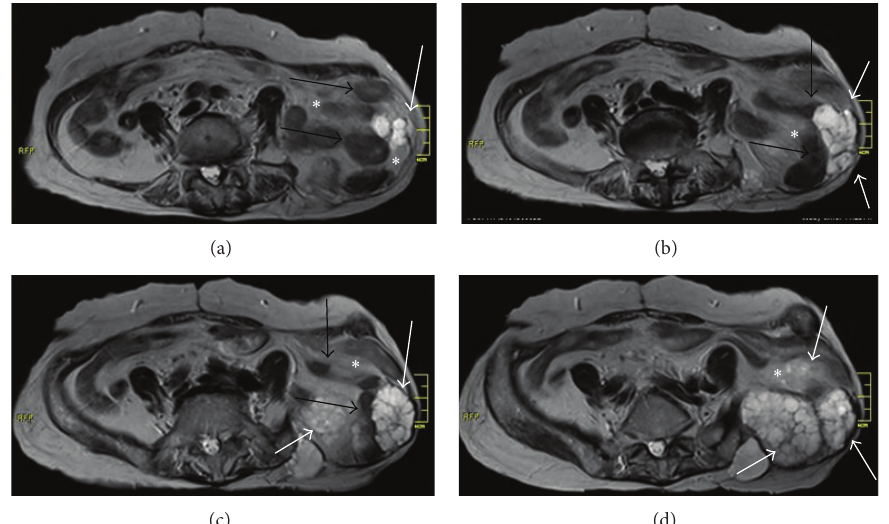
Figure 2: White arrows show tumoral mass (chondrosarcoma mass), black arrows show intestine or colon, and asterisk shows mesenteric fatty tissue.